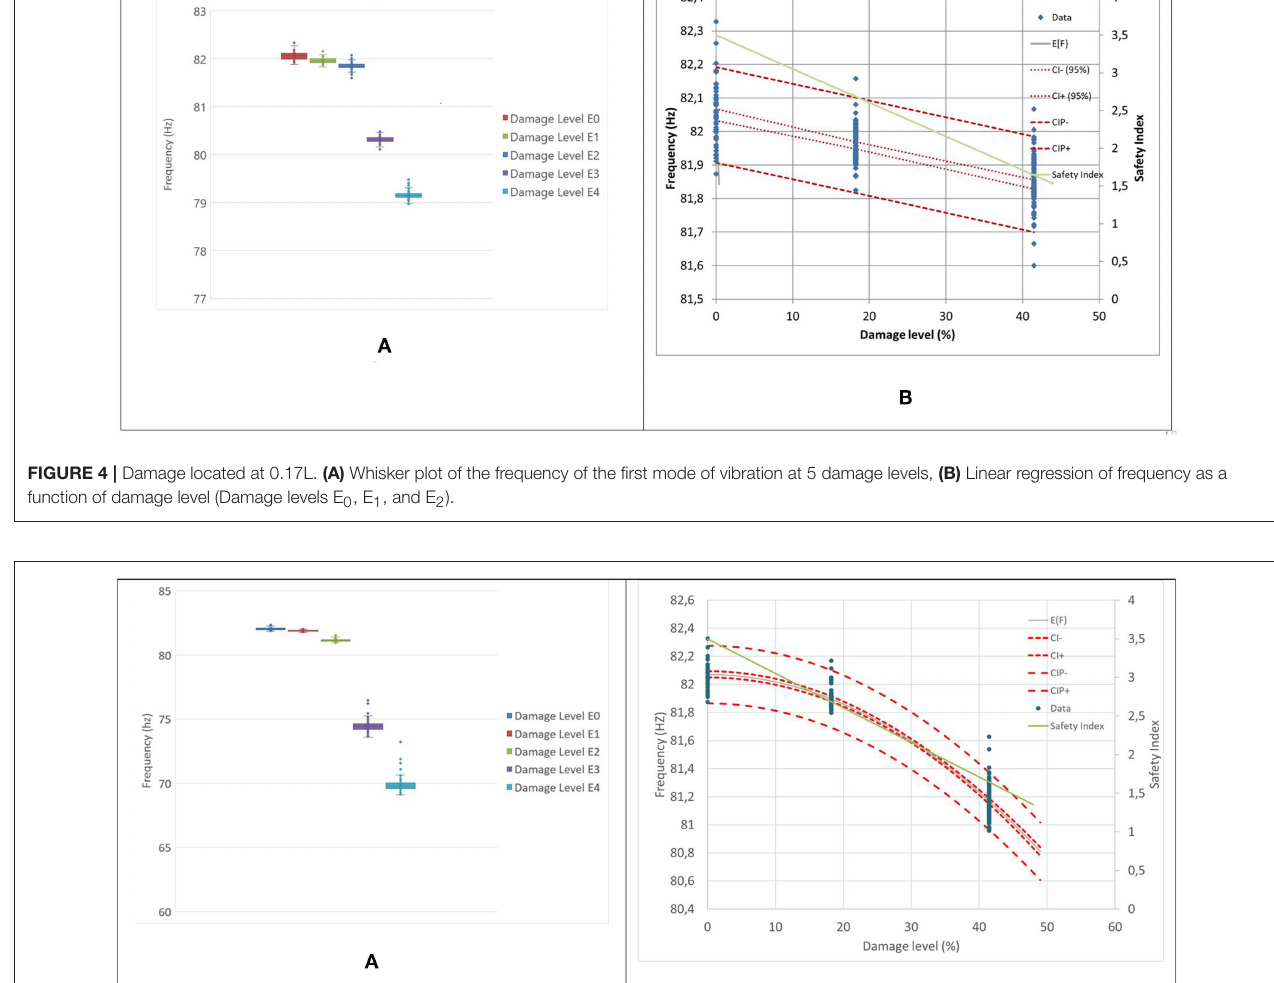
when damage is located at 0.17L data ( Figure 4A ). The trend